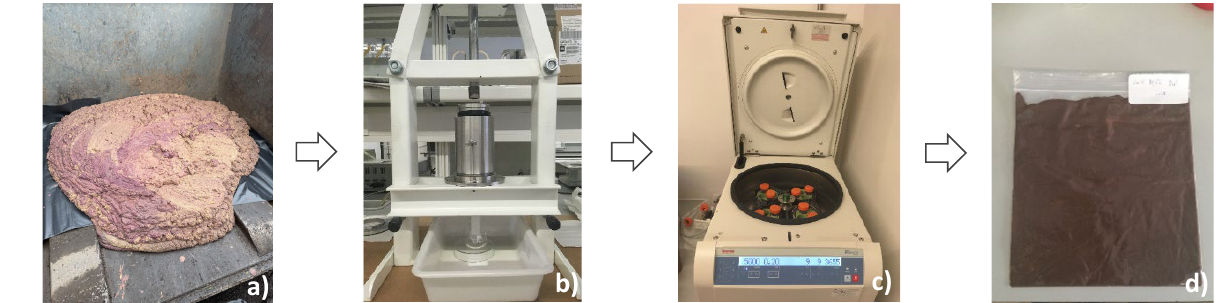
Figure 1. Summary of the steps employed to obtain the semi-solid paste (SSP) from fresh olive pomace. ( a ) fresh olive pomace ( b ) hydraulic press; ( c ) centrifugation; ( d ) SSP.